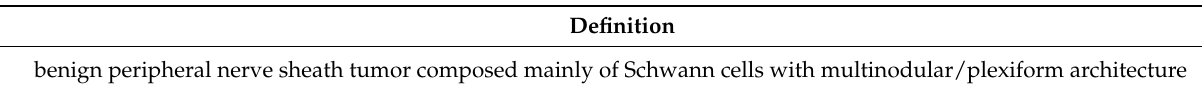
Table 5. Key diagnostic features of plexiform